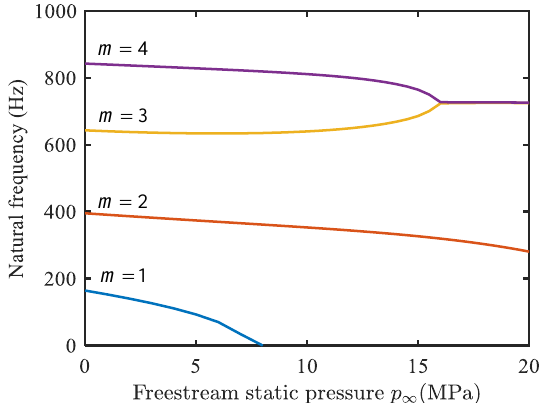
Figure 4. Natural frequency versus free-stream static pressure for a conical shell with different modes ( p = 1).